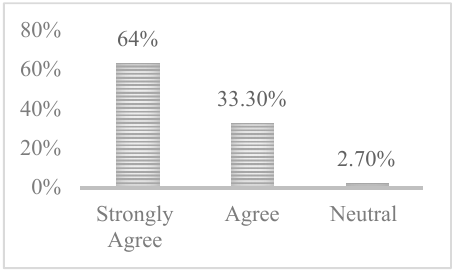
Figure 6. FoMO-R usability.